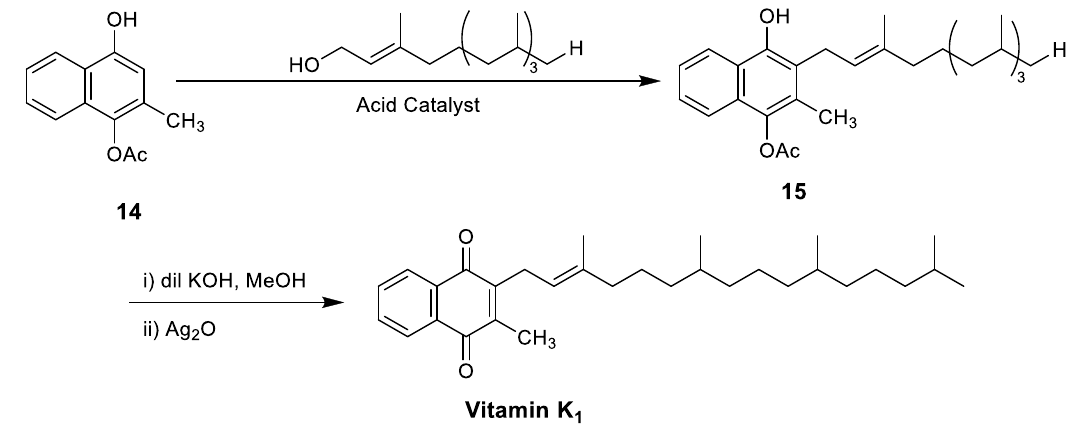
Table 1. Yields for different acid catalysts used in the synthesis of vitamin K 1 [54]. Acid Catalyst % Yield 1 KHSO 4 55% Oxalic Acid N/A 2 Duolite C-60 8% BF 3 ∙OEt 2